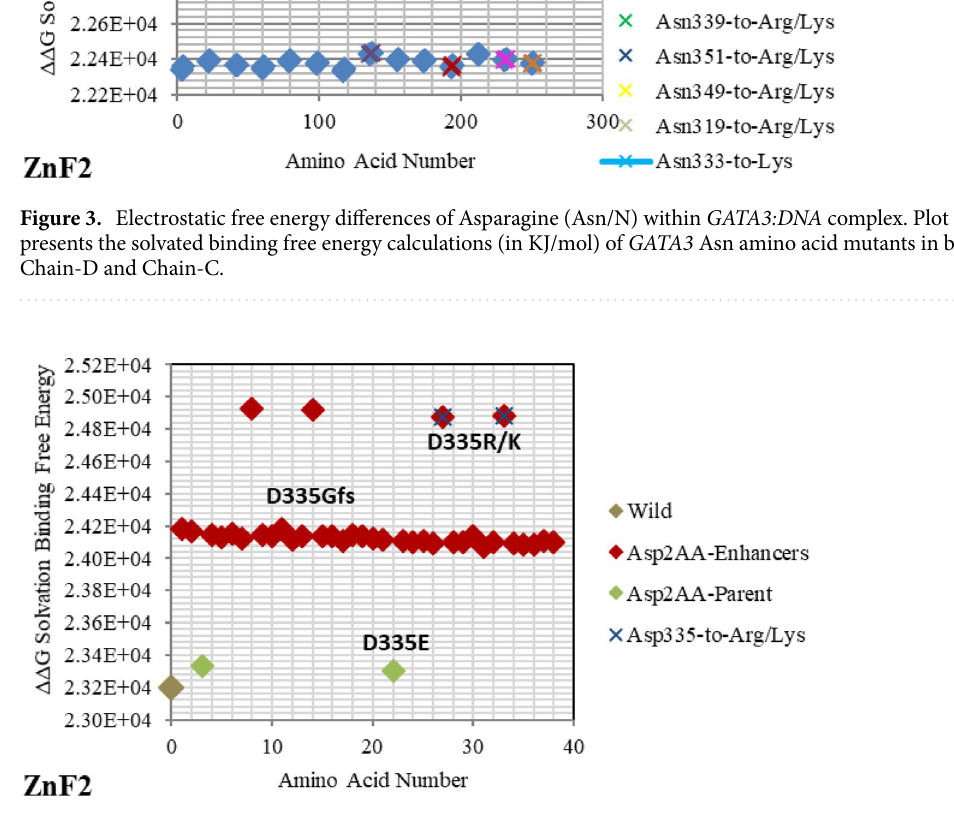
Figure 4. Electrostatic free energy differences of Aspartic Acid (Asp/D) within GATA3:DNA complex. Plot presents the solvated binding free energy calculations (in KJ/mol) of GATA3 Asp amino acid mutants in both of Chain-D and